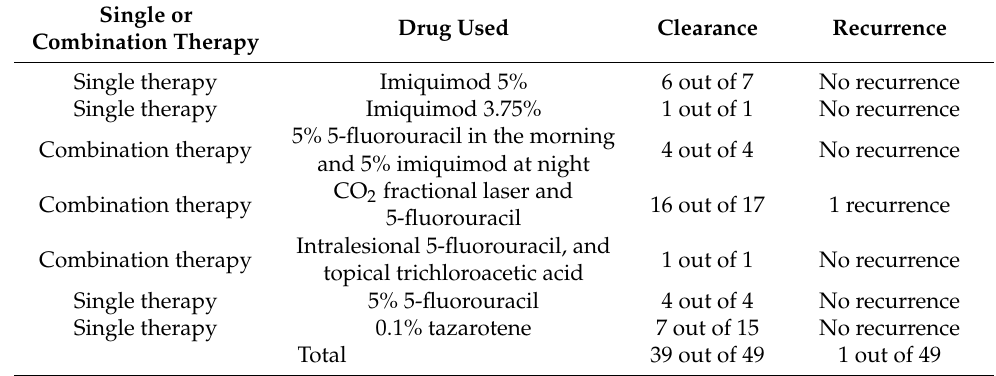
Table 1. Data analysis from the